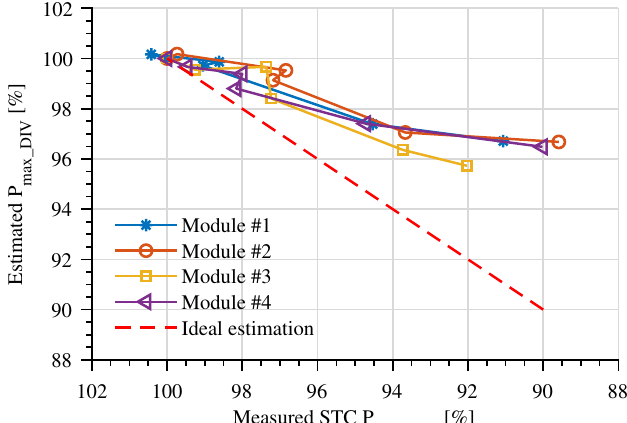
Figure 10. Comparison of estimated module power loss by dark I-V superposition ( P max _ DIV ) and series resistance compensation (dark I-V estimated - R s _ DIV ), versus actual measured STC power loss ( P max _ LIV ), for all for